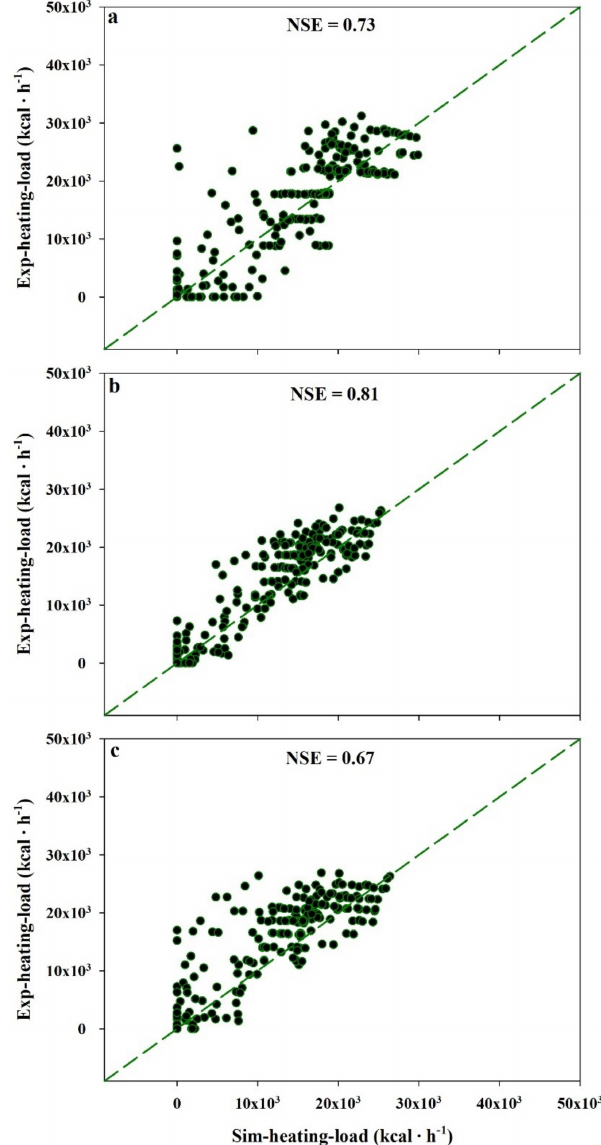
Figure 10. Statistical analysis of measured vs. computed heating loads of greenhouse ( a ) compartment 1, ( b ) compartment 2, and ( c ) compartment